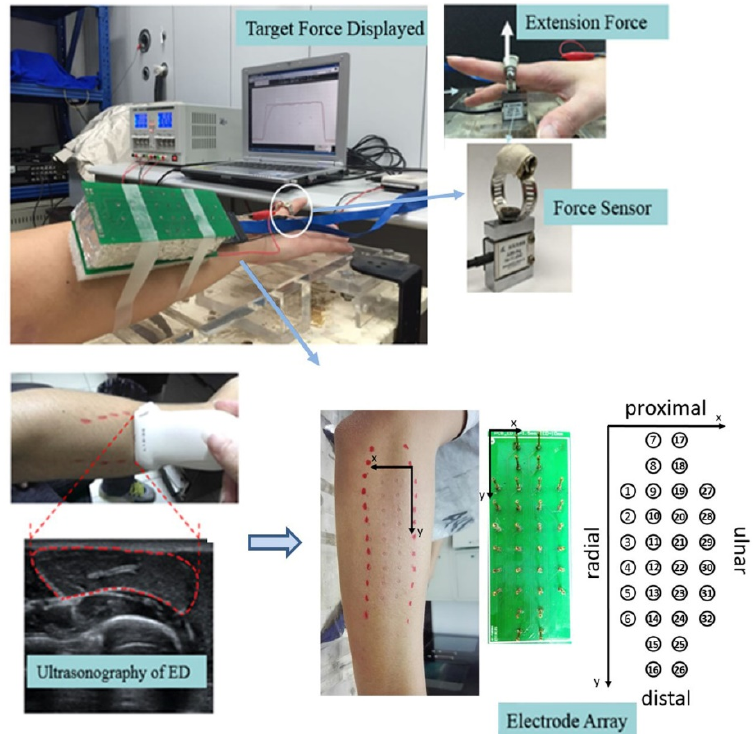
Figure 1. The scene of the experiment for sustained force-tracking through right index finger extension. The extension force of index was detected with a custom-made ring-like force sensor, and the sEMG was recorded with 32-channel circular electrodes of test probes. The edge of superficial region of ED muscle was identified using